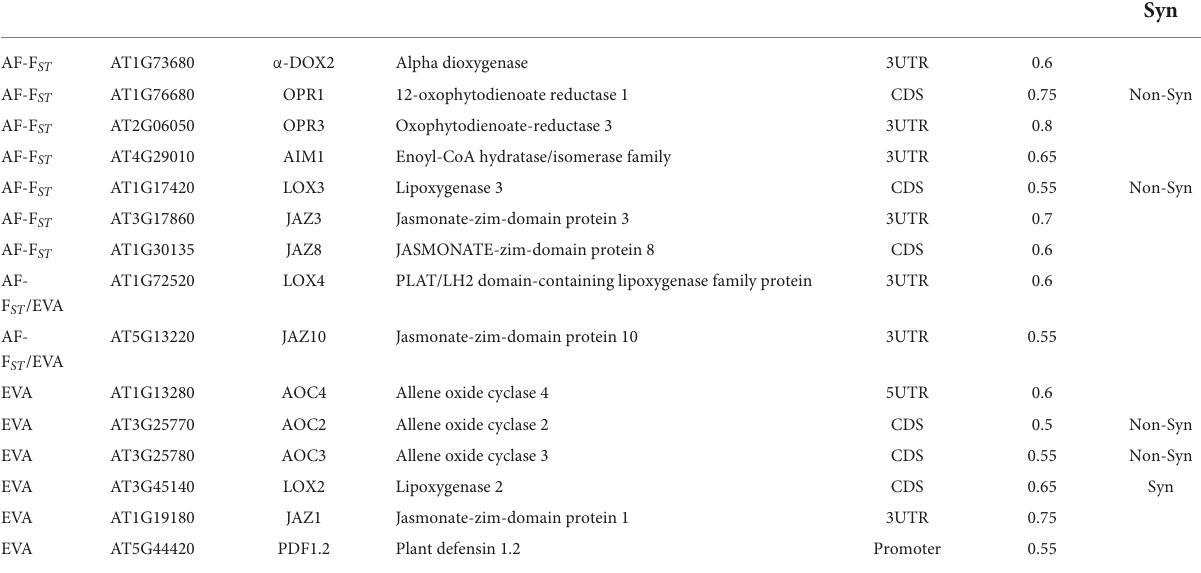
TABLE 5 Loci associated with jasmonic acid metabolism and transduction